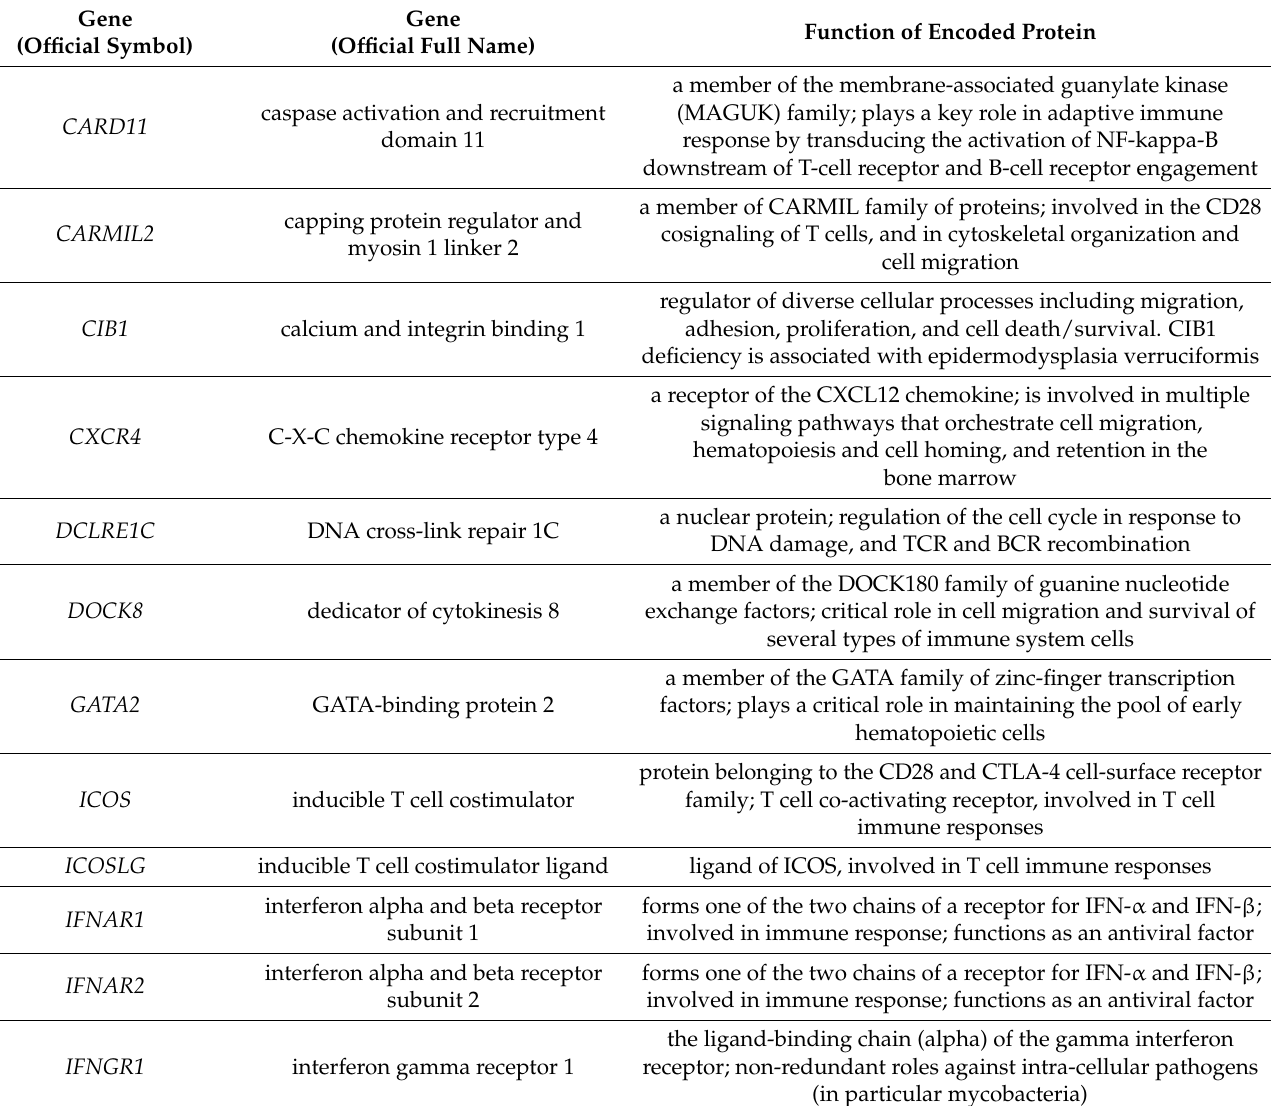
Table 2. Summary of the discussed